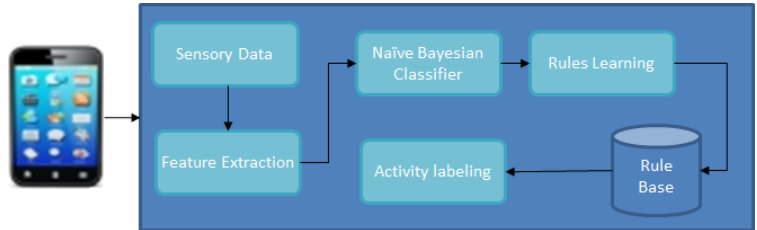
Figure 3. Architecture for training and testing